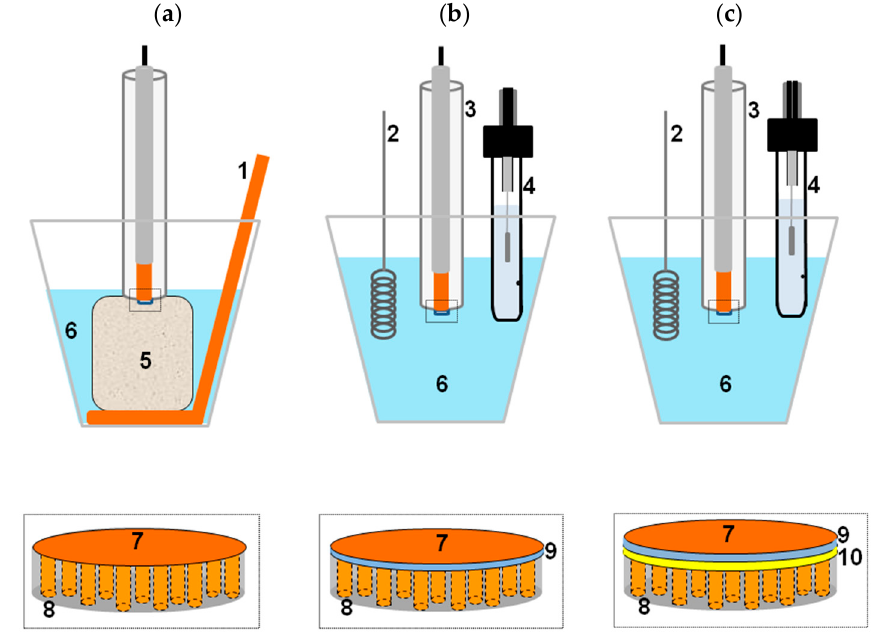
Figure 2. Scheme illustrating three template deposition methods used which differ for the way used to contact the PC membrane (8) to the flat disk Cu electrode (7). From left to right: ( a ) adhesion by the pressure furnished by the melamine foam (5); ( b ) adhesion by using a Nafion interlayer (9) as polyelectrolytic glue; ( c ) as ( b ), but using a PC membrane pre-sputtered with the gold interlayer (10). Other components: (1) Cu counter electrode; (2) Pt counter electrode; (3) working electrode; (4) Ag/AgCl KCl sat reference electrode; (6) 0.4 M CuSO 4 , 0.01 M H 2 SO 4 solution (reprinted with permission from [29]).